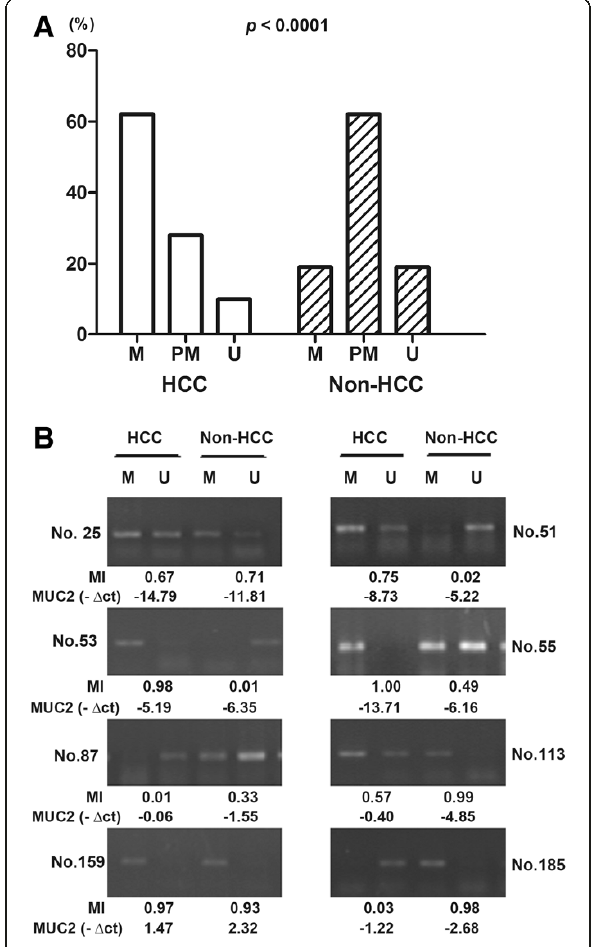
Figure 2 The promoter methylation of MUC2 in HCC tissues and non-tumor tissues by MSP. ( A ) Methylation of MUC2 promoter in HCC and corresponding non-carcinoma tissues. M, hypermethylation; PM, partial methylation; U, unmethylation; ( B ) Representative patterns of MUC2 promoter methylation. U, reaction specific for unmethylated DNA; M, reaction specific for methylated DNA. MI, The methylation index. - Δ Ct, - (CT MUC2 - CT β -actin